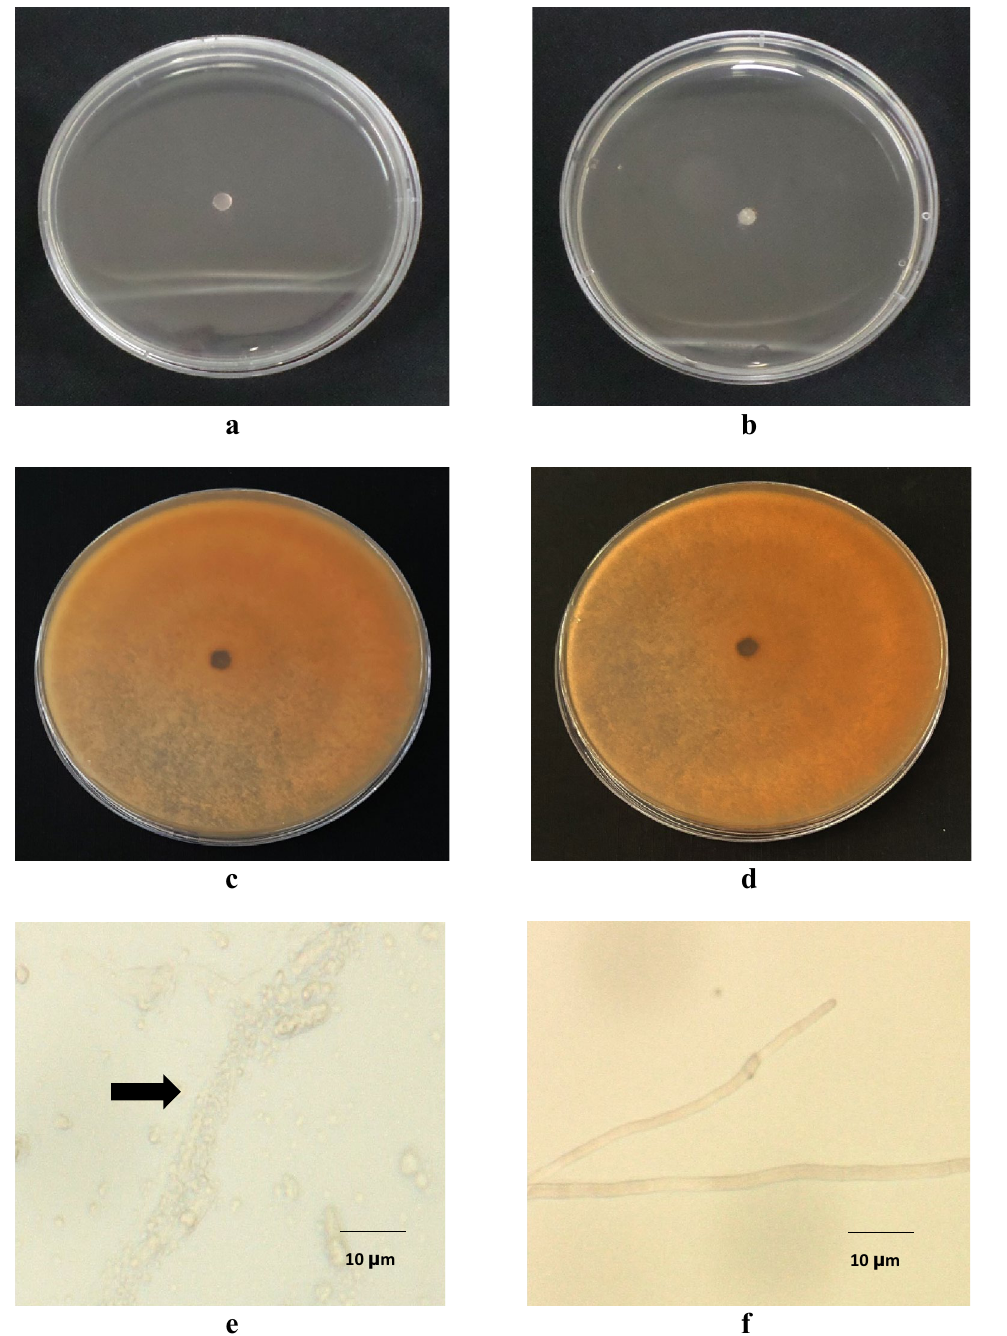
Figure 2. Test pathogen treated with ( a ) CWE at 1.50 gL −1 , ( b ) Mancozeb 2.50 gL −1 , ( c ) EOH, ( d ) untreated mycelial plug, ( e ) mycelia treated with CWE, ( f ) untreated